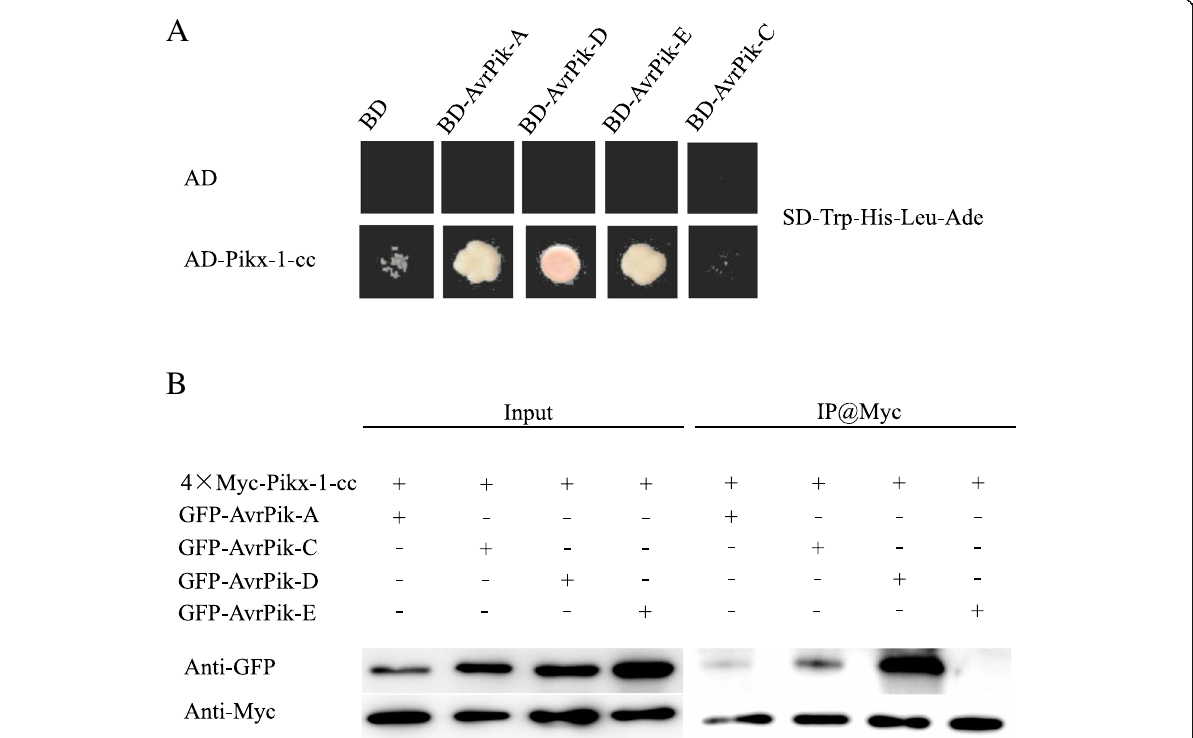
Fig. 5 Interaction detection between Pikx and four AvrPik proteins in yeast and in planta a Y2H analysis of the interaction between Pikx-1 cc domain and four AvrPik alleles. b Co-IP analysis of the interaction between Pikx-1 cc domain and four AvrPik alleles in N.